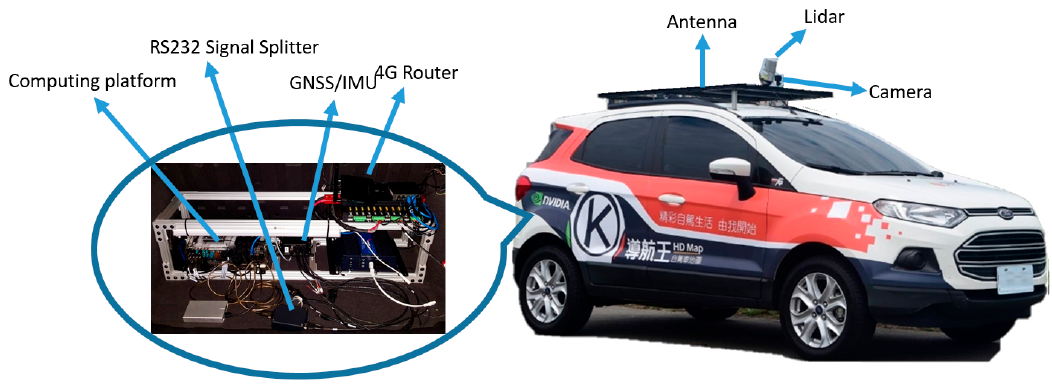
Figure 3. Key components of the proposed MMS.